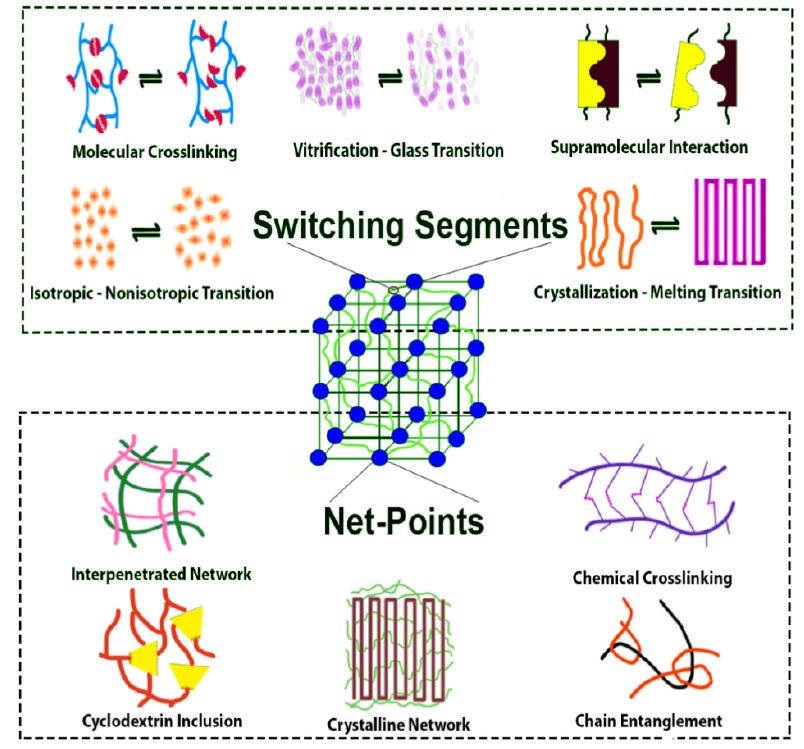
Figure 2. Shape-memory polymers architecture and possible transitions [9].